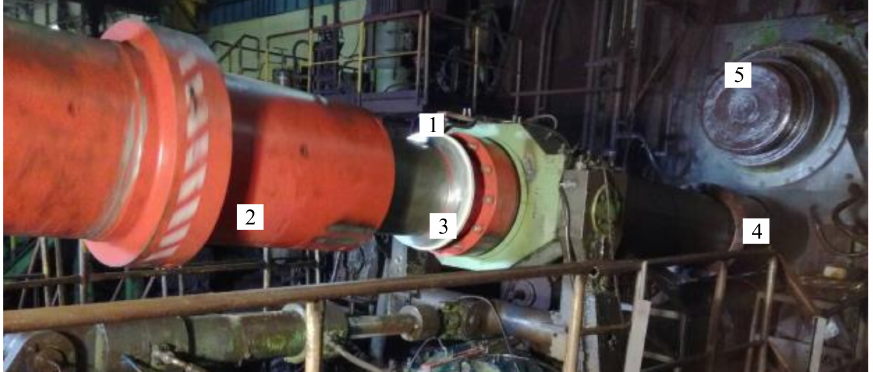
Figure 2. Spindle of a horizontal stand, Mill 5000: 1 is the sensor; 2 is the spindle shaft; 3 is the telemetry ring; 4 is the spindle head; 5 is the upper backup